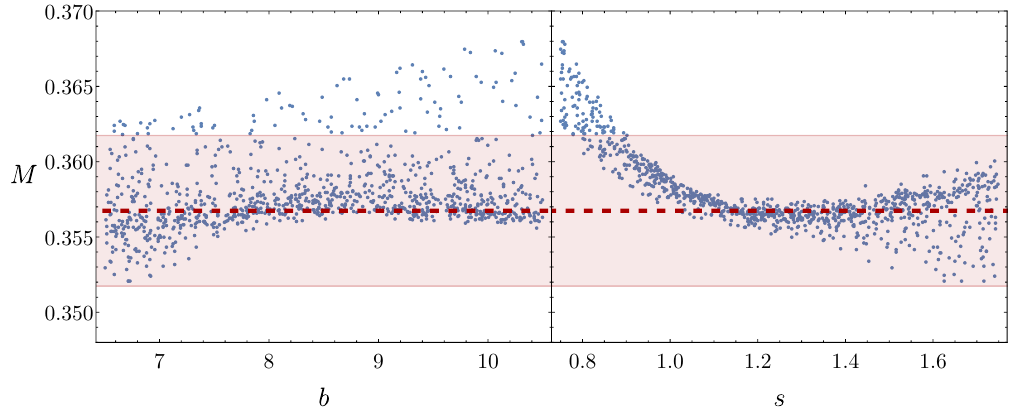
Figure 3 . Estimate of the error in the resummation of the physical mass at coupling g = 2. The blue points are the values of F ( N =8) as function of the parameters s and b . The red dashed line is B;k the central value of the resummation obtained for s 0 = 5 = 4, b 0 = 17 = 2. The red band is the (cid:12)nal error on the resummation computed as in